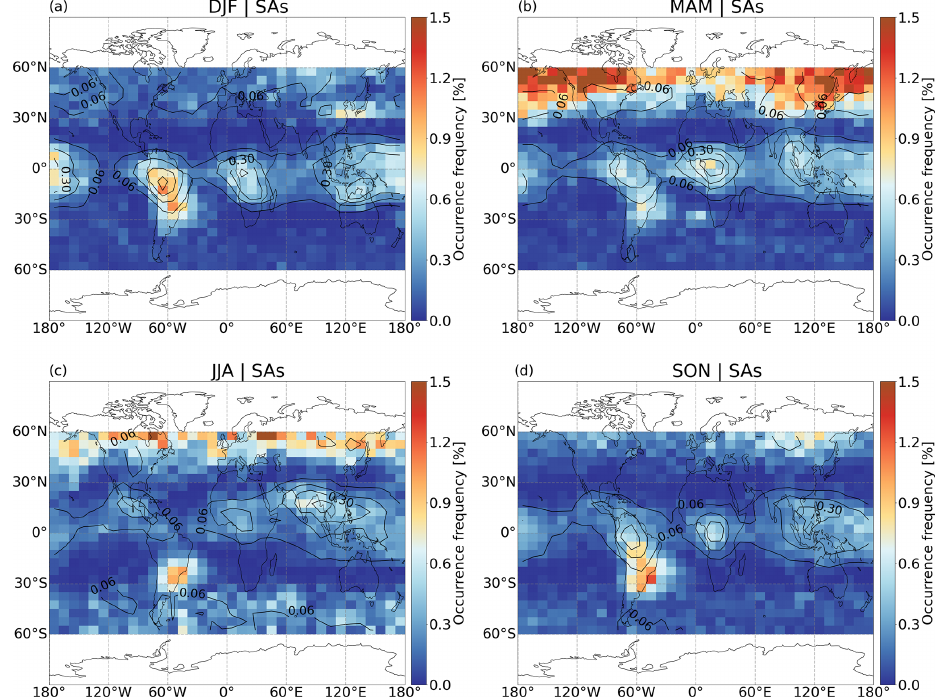
Figure 8. Seasonal occurrence frequency of stratospheric aerosols from CALIPSO during 2007–2019. Black contours are the occurrence frequencies of SICs, as shown in Fig.